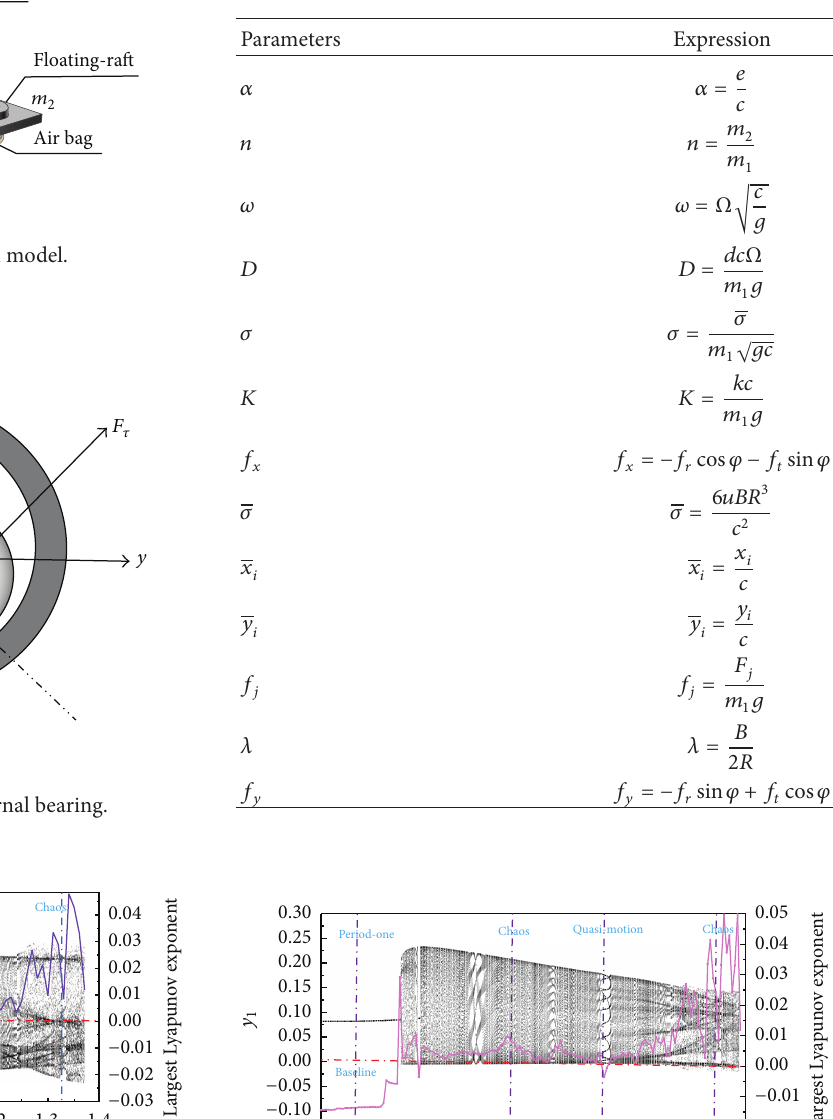
Table 1: The non-dimensional expressions of parameters.